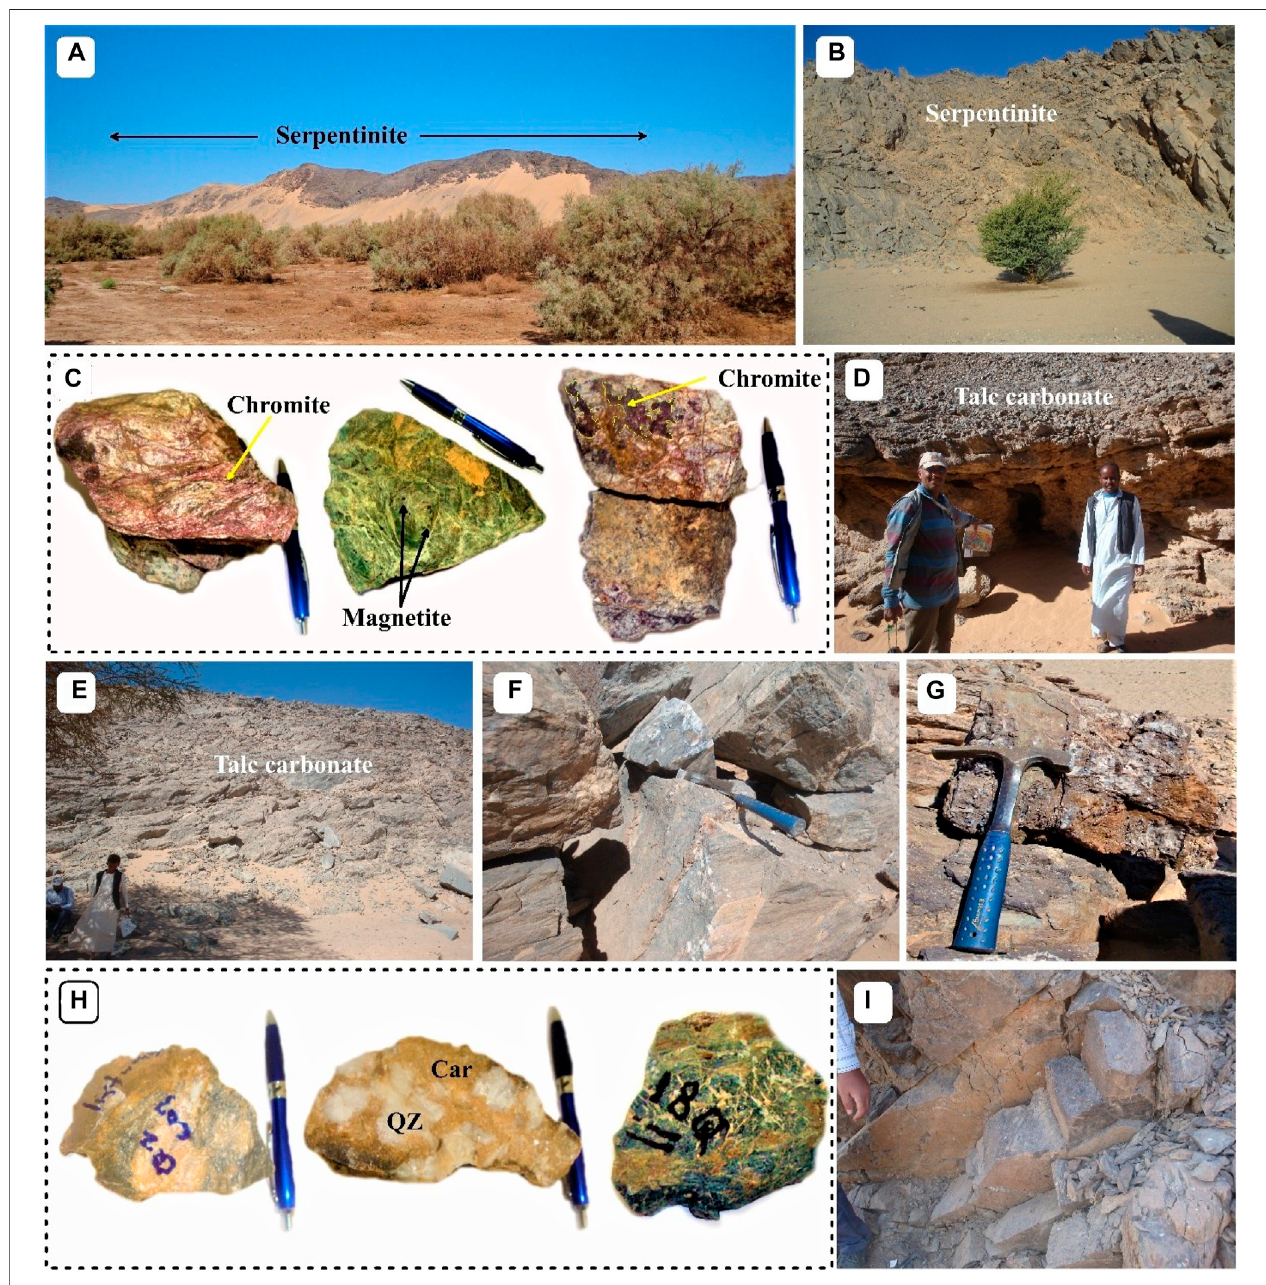
FIGURE 3 | Field photograph showing the studied rocks: (A,B) Continuous ridge of serpentinite rocks (Looking N-W). (C) Magnetite and chromite bearing serpentinitesamplesalongashearzone. (D) Talc-carbonaterocksexhibitingtheconspicuous cavernous structure (LookingN-W). (E) Creamy talccarbonates(Looking N-W). (F) Massive listwaenite rocks. (G) Porous listwaenite. (H) Different types of listwaenite rocks. (I) Exposed surface of colonnade columnar joints in amphibolites.